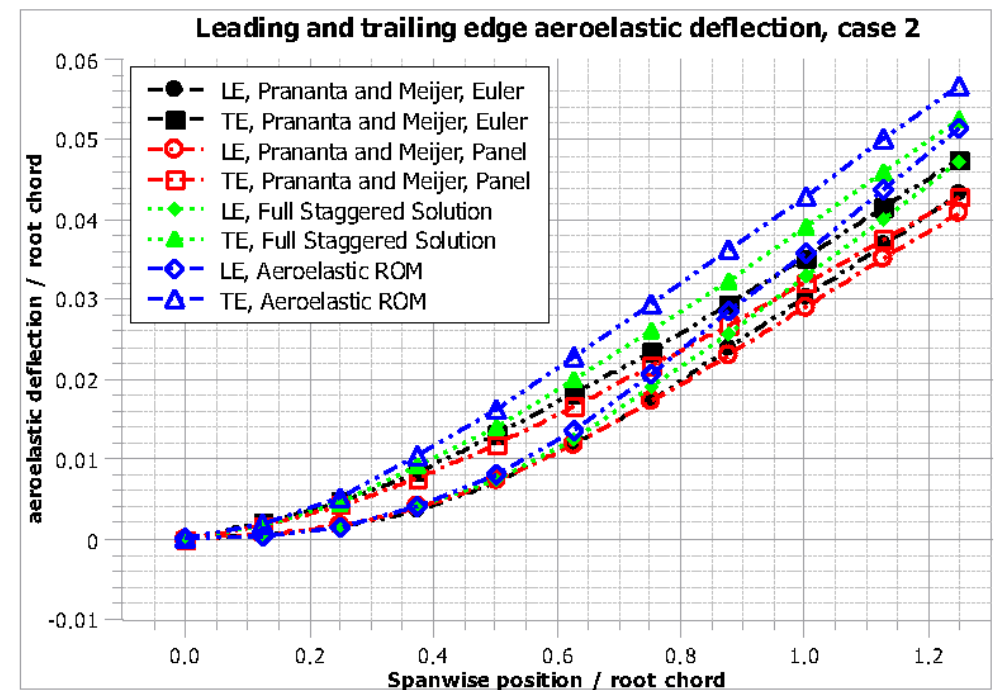
Figure 13. AGARD wing Case 2: normalized static aeroelastic displacement plot, leading (LE) and trailing (TE)